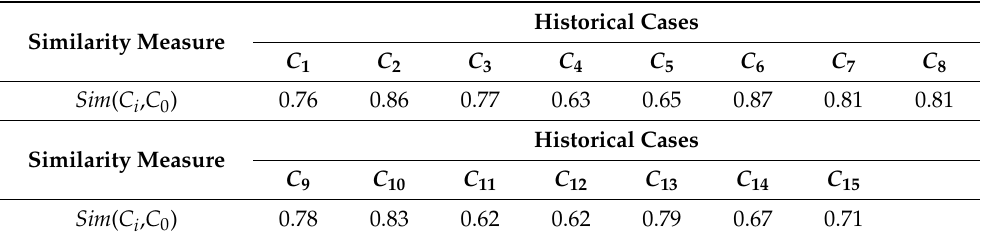
Table 6. Hybrid similarity measure Sim ( C i , C 0 ) between historical enforcement cases C i and target enforcement case C 0 .